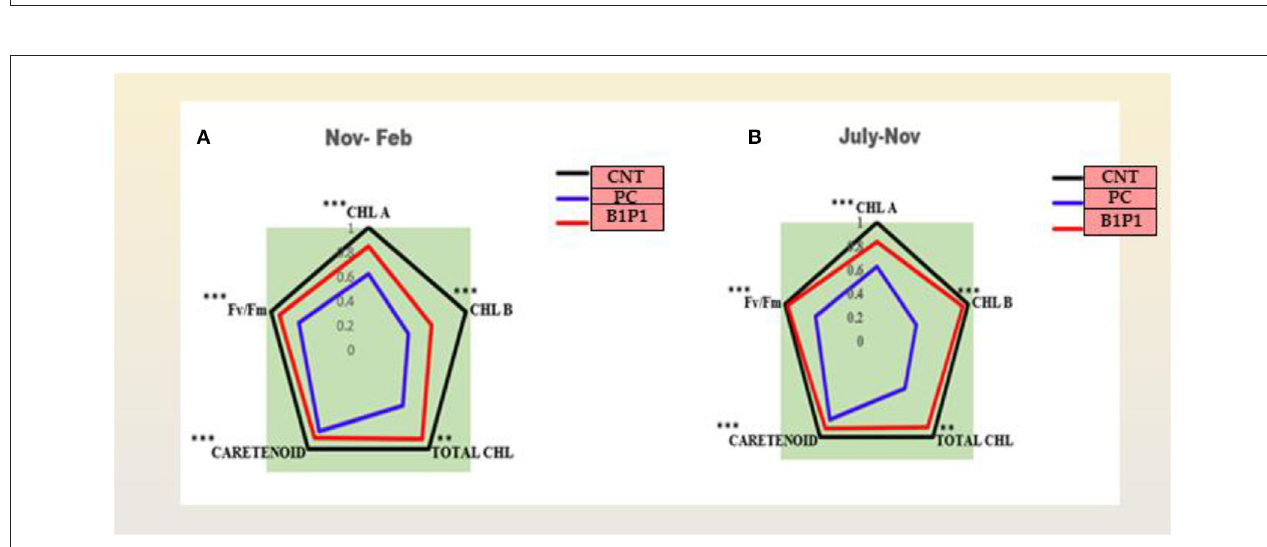
FIGURE 5 | (A,B) Effect of different treatments on chlorophyll a, chlorophyll b, total chlorophyll, carotenoids, and Fv/Fm in two different consecutive seasons. Radar charts depict changes in the relative content of the pigments in three treatments in two seasons. The relative content was evaluated as a ratio of each content of pigment to its control. Values are calculated as a mean of n = 3. Asterisks represent the significance (***significant at p < 0.01, **significant at p < 0.001) using a one-way ANOVA.